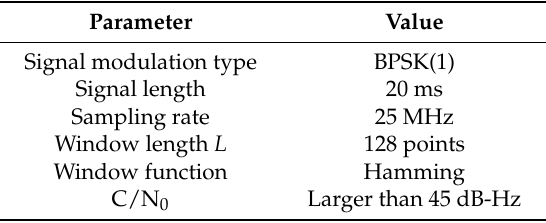
Table 2. Setting of Multipath Parameter Estimation.